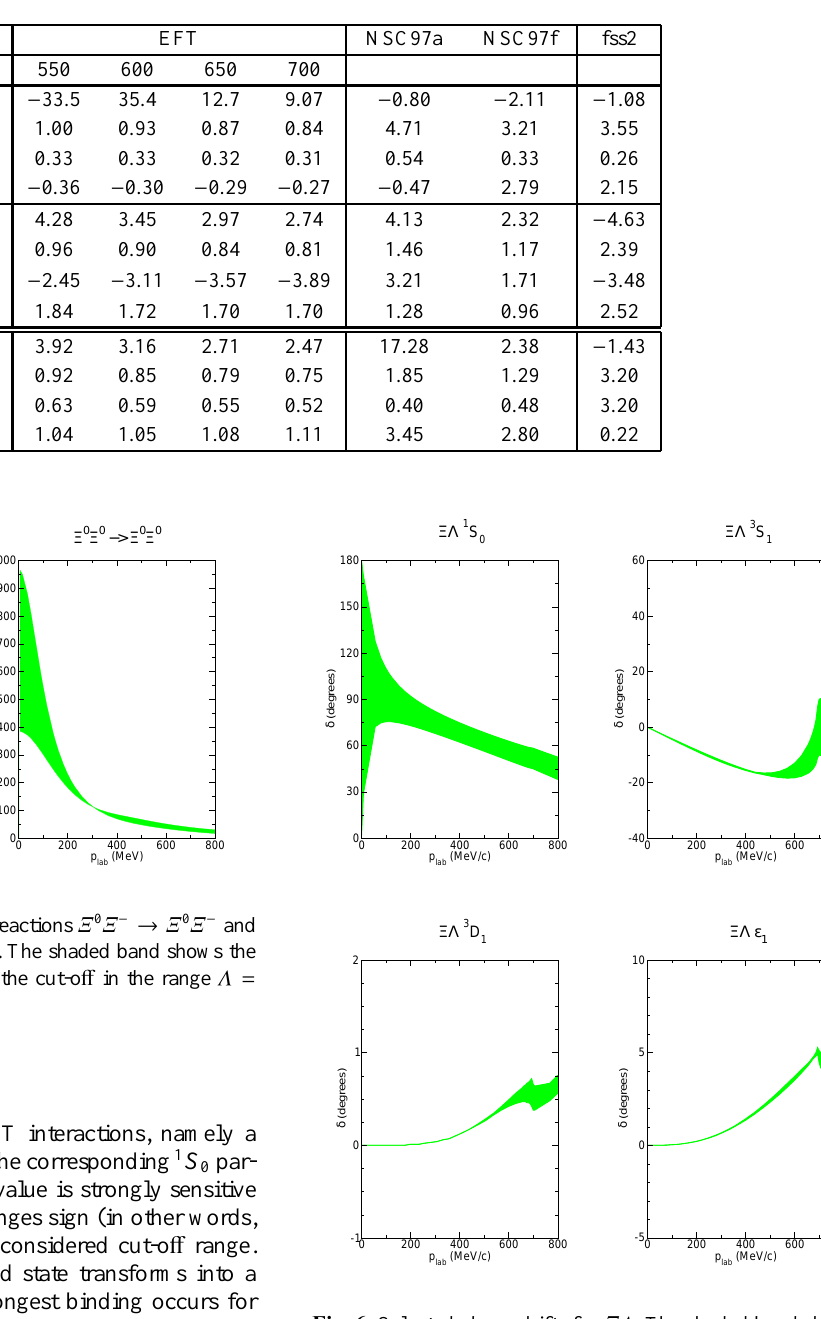
Fig. 6. Selected phase shifts for ΞΛ . The shaded band shows the chiral EFT results to LO for variations of the cut-o ff in the range Λ = 550 . .. 700